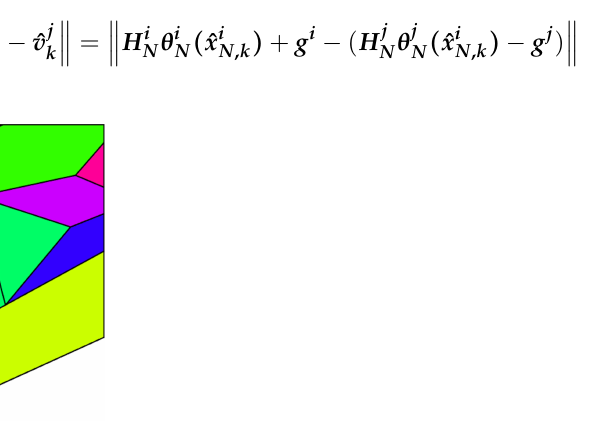
result in the same flux value and γ ( i , j , k ) will be zero. A schematic example is shown in Figure 3. Polygons in different colors represent different critical regions in the parameter space Θ . As the state evolves with time, the corresponding θ changes along the dash line in the parameter space Θ . As the θ approaches the boundary between the critical region Θ 1 and Θ 2 , γ ( i , j , k ) approaches zero. Correspondingly, a value of γ ( i , j , k ) smaller than a user specified tolerance indicates a switch between critical regions, thus requiring reinitialization of the EKF as follows: ˆ x j is set equal to ˆ x i and P j is set equal to P i . N , k k N , k k